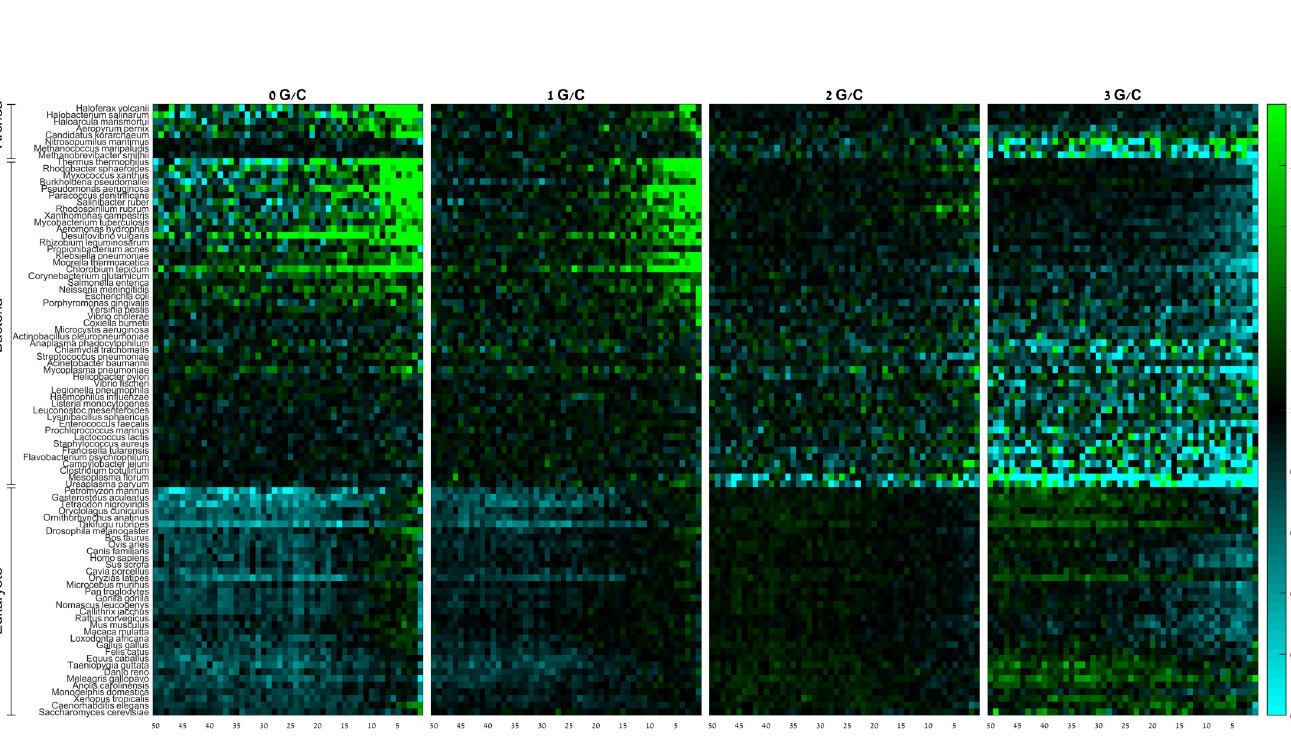
PLOS ONE | https://doi.org/10.1371/journal.pone.0225633 December4,